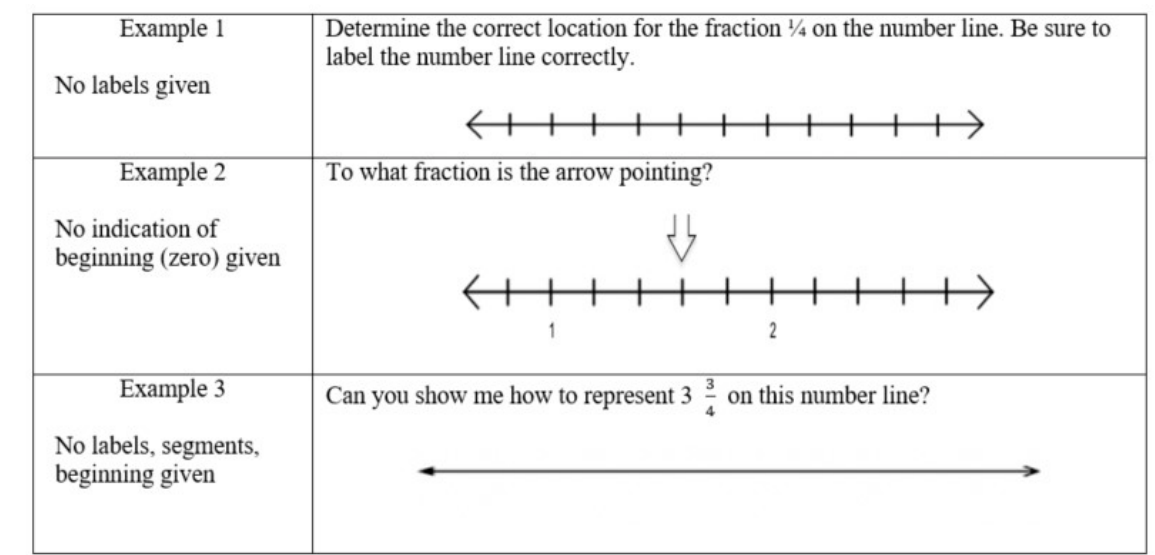
Figure 6. Strategies that omit various components of the number line in Question 2.